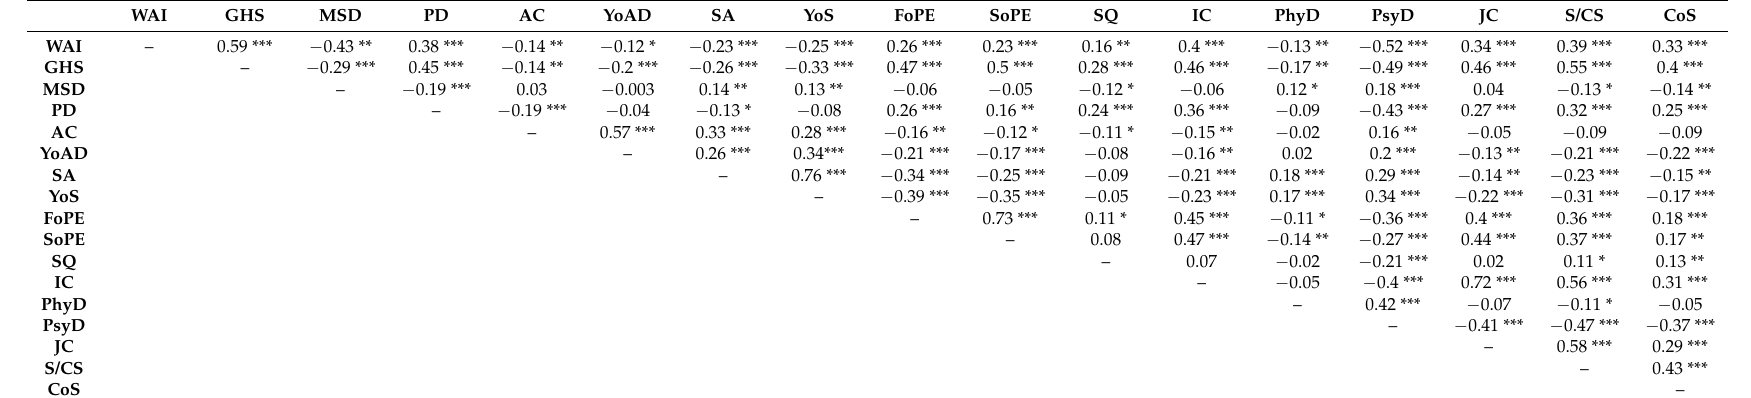
Table 4. Pearson’s correlation analysis for different individual and work-related